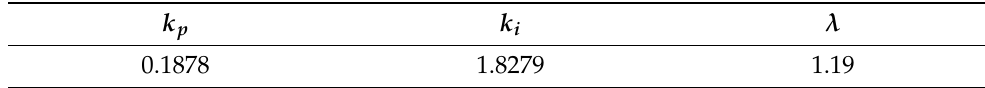
Table 1. Fractional order controller